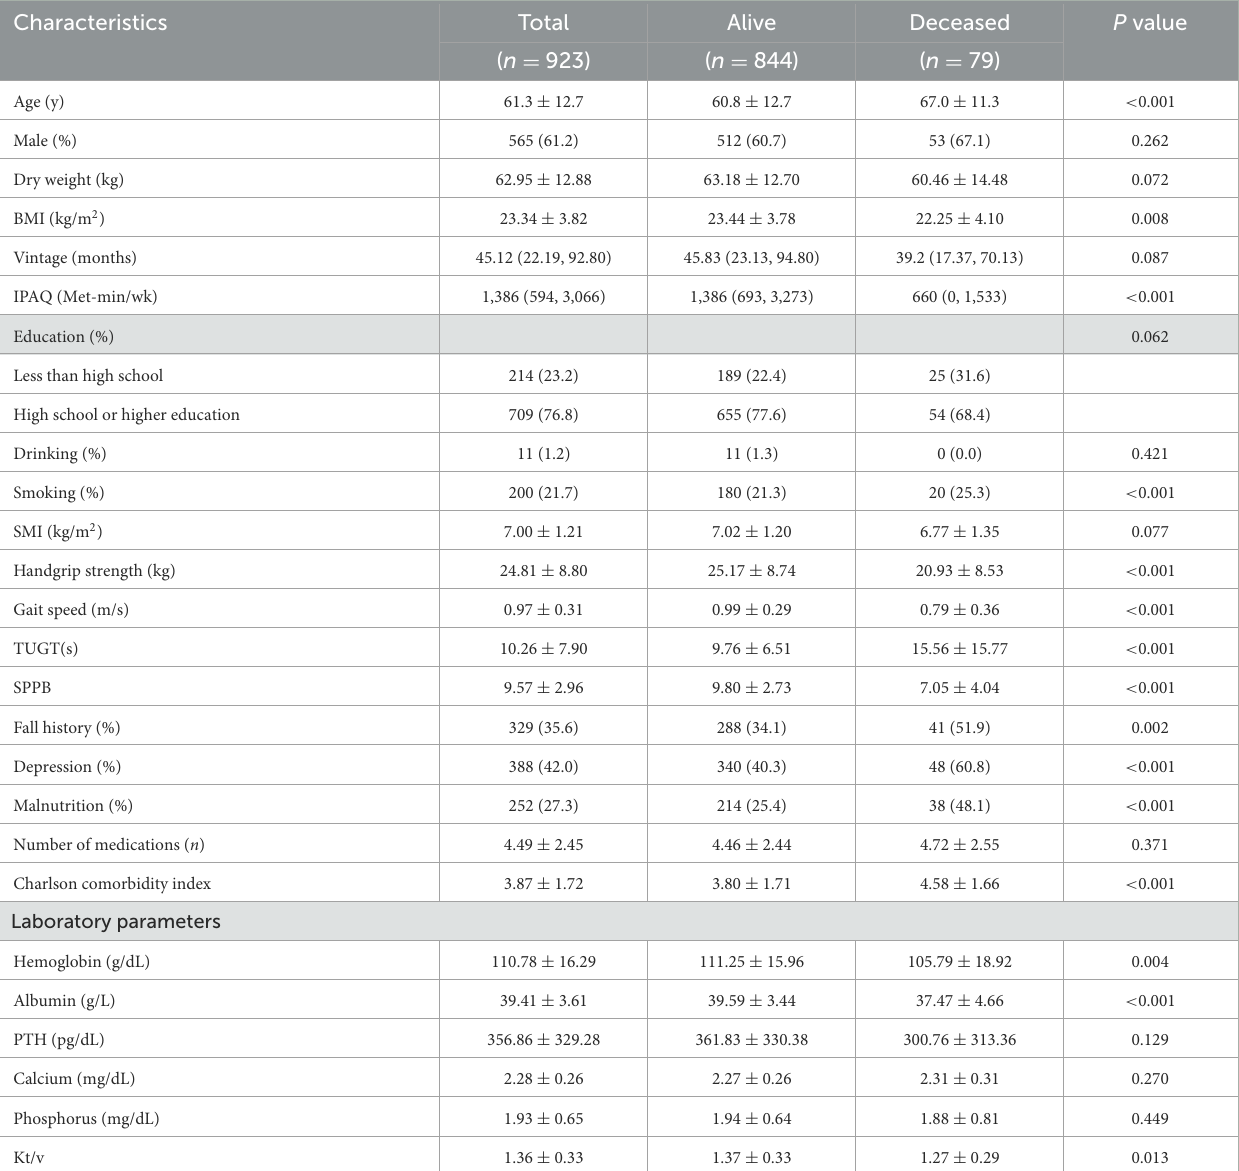
TABLE 1 Baseline characteristics of study participants according to the presence of mortality. Characteristics